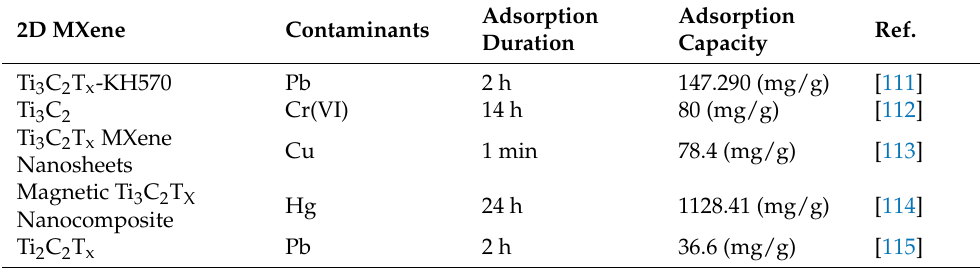
Figure 3. Metal ions adsorption by MXene [132]. Table 2. Application of MXene in heavy metals removal.